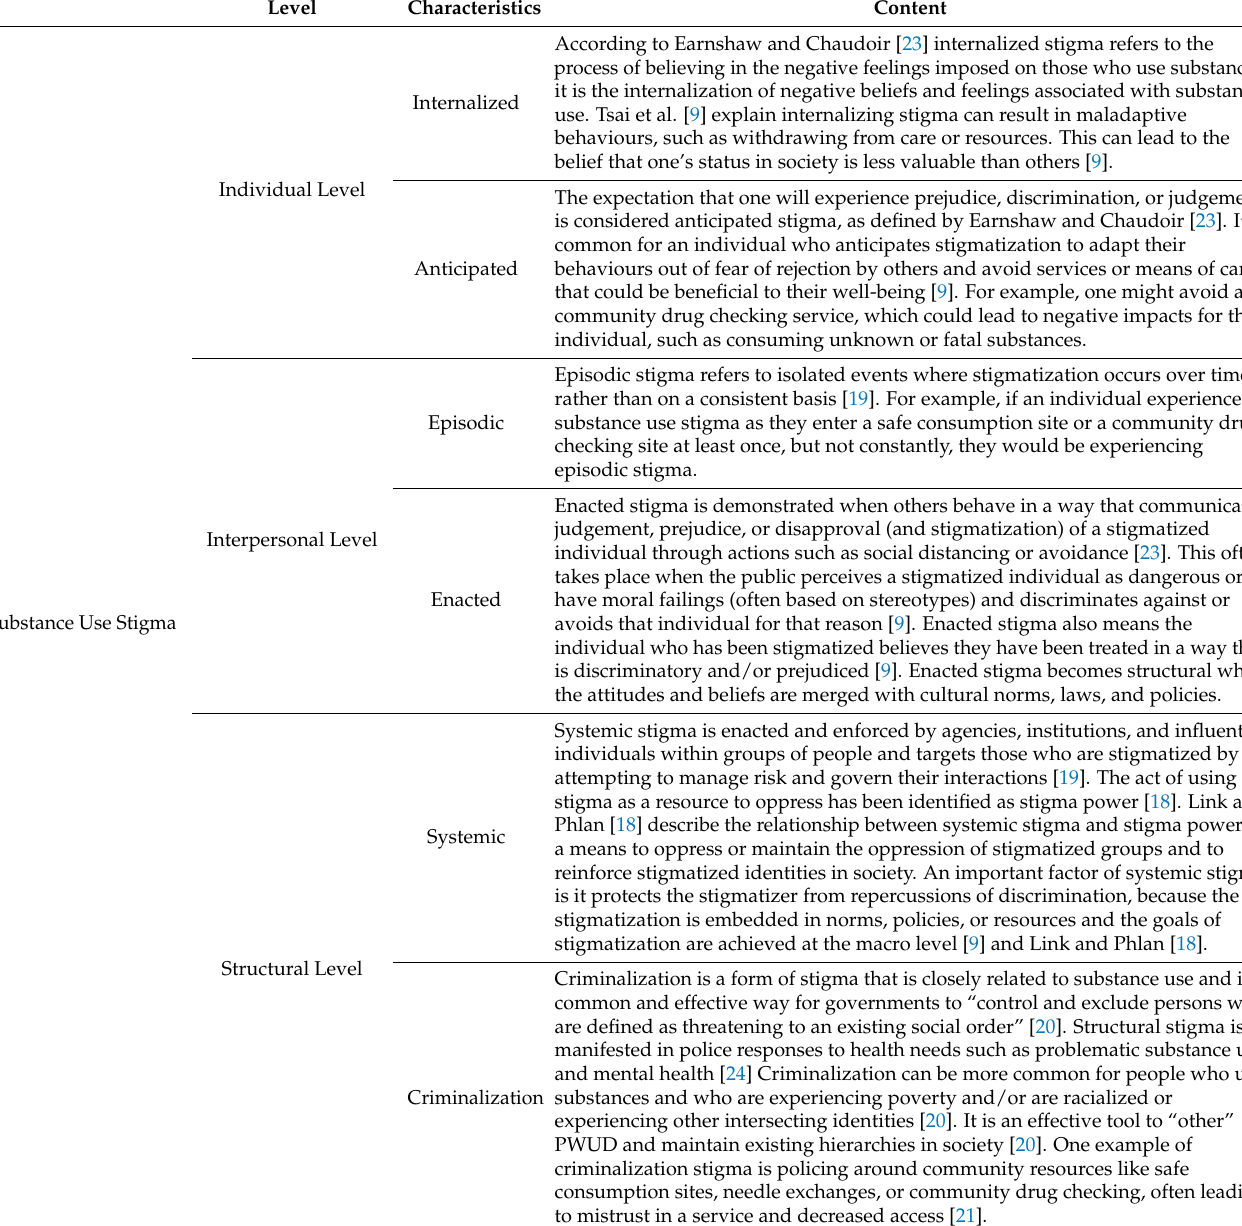
Table 1. Analytical